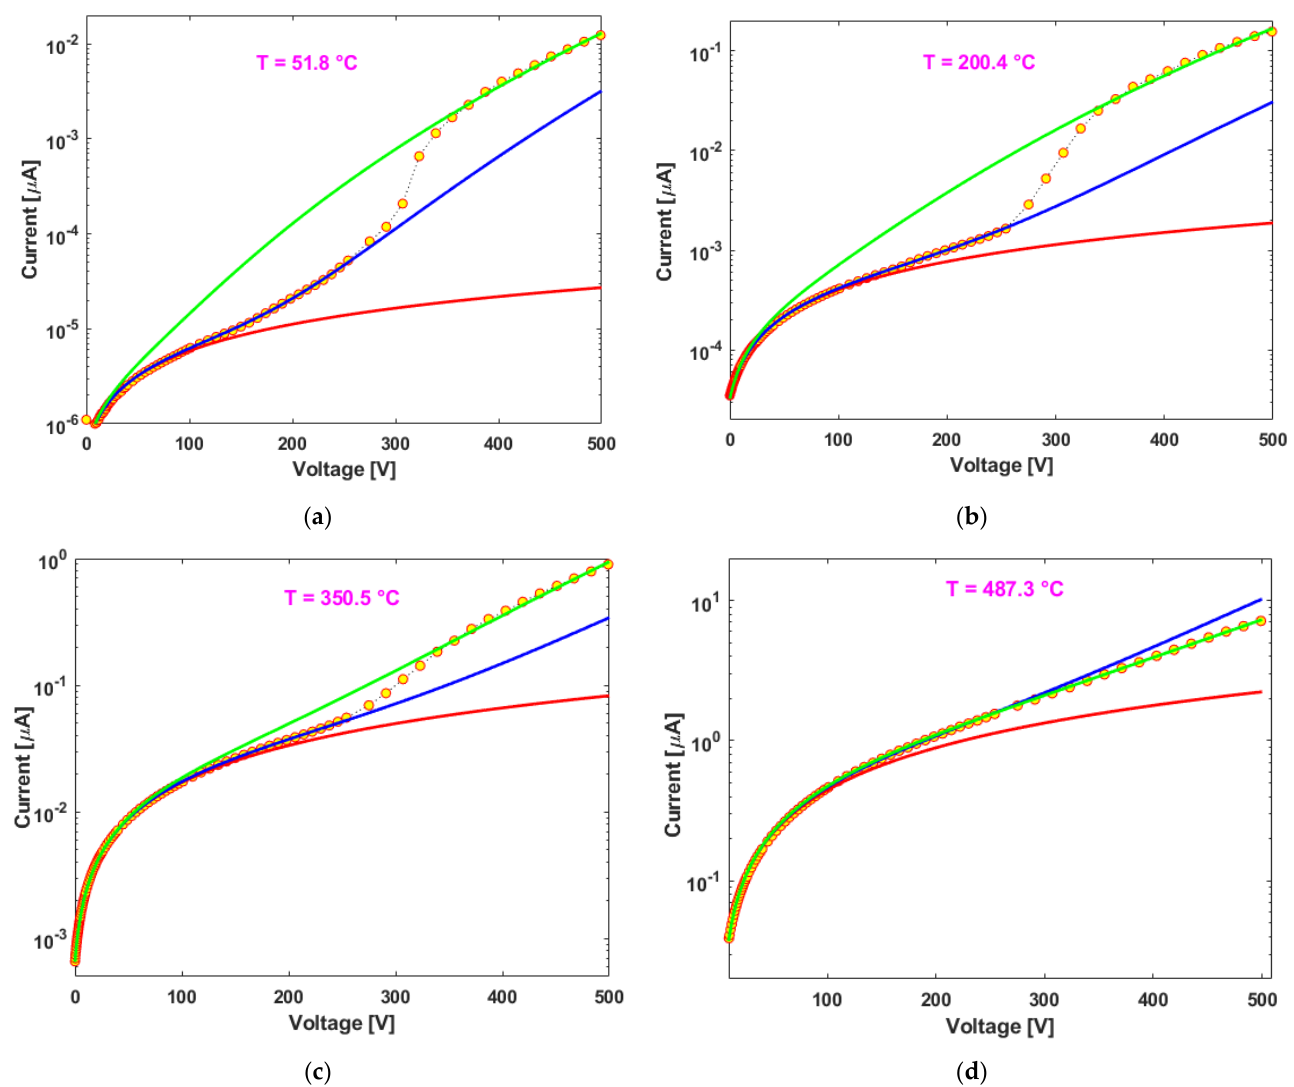
Figure 6. I/V curves relative to the positive voltage ramp with corresponding Matlab fitting for the linear part (red line), the first exponential part up to 230V (blue curve) and the total exponential behavior up to maximum voltage of 500 V (green curve). ( a ) measurement at about 50 °C; ( b ) measurement at about 200 °C; ( c ) measurement at about 350 °C; ( d ) measurement at about 500 °C.